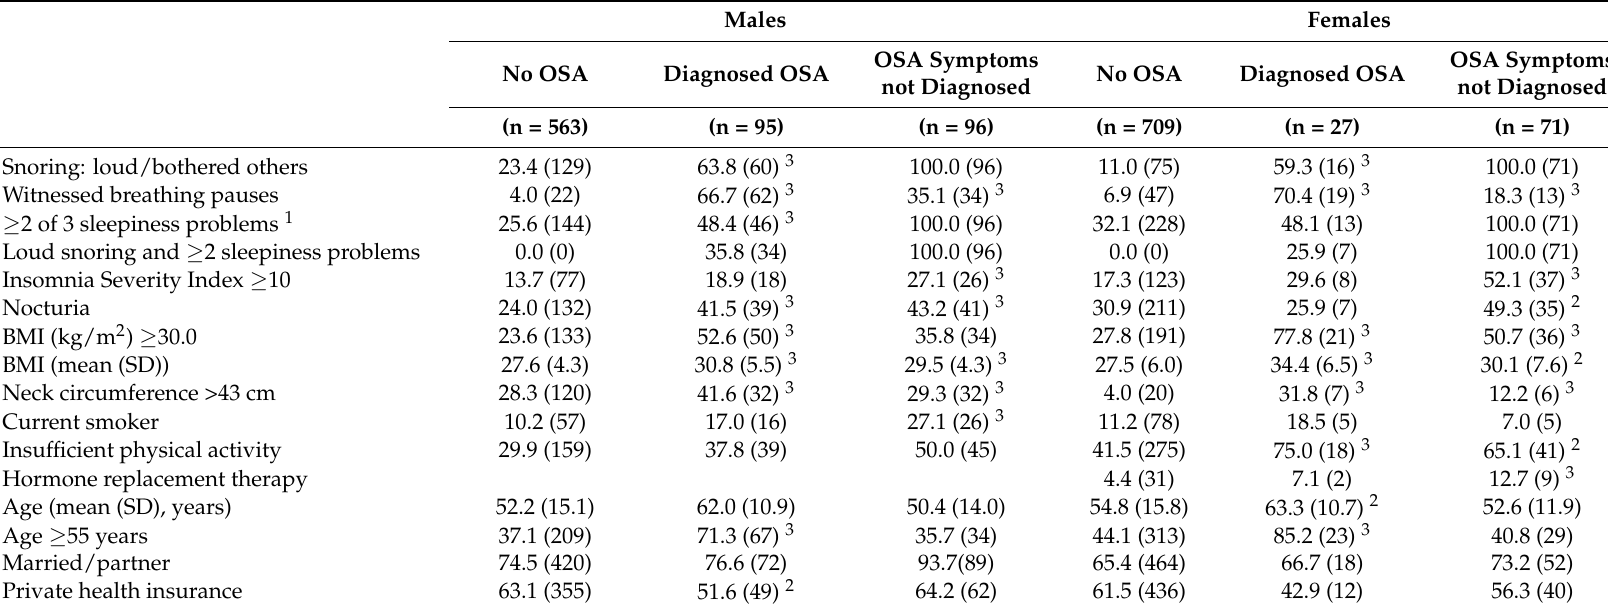
Table 2. Symptom and demographic characteristics (% (n)) of participants with diagnosed obstructive sleep apnea (OSA) and OSA symptoms (snoring and daytime sleepiness 1 ) not previously diagnosed, by